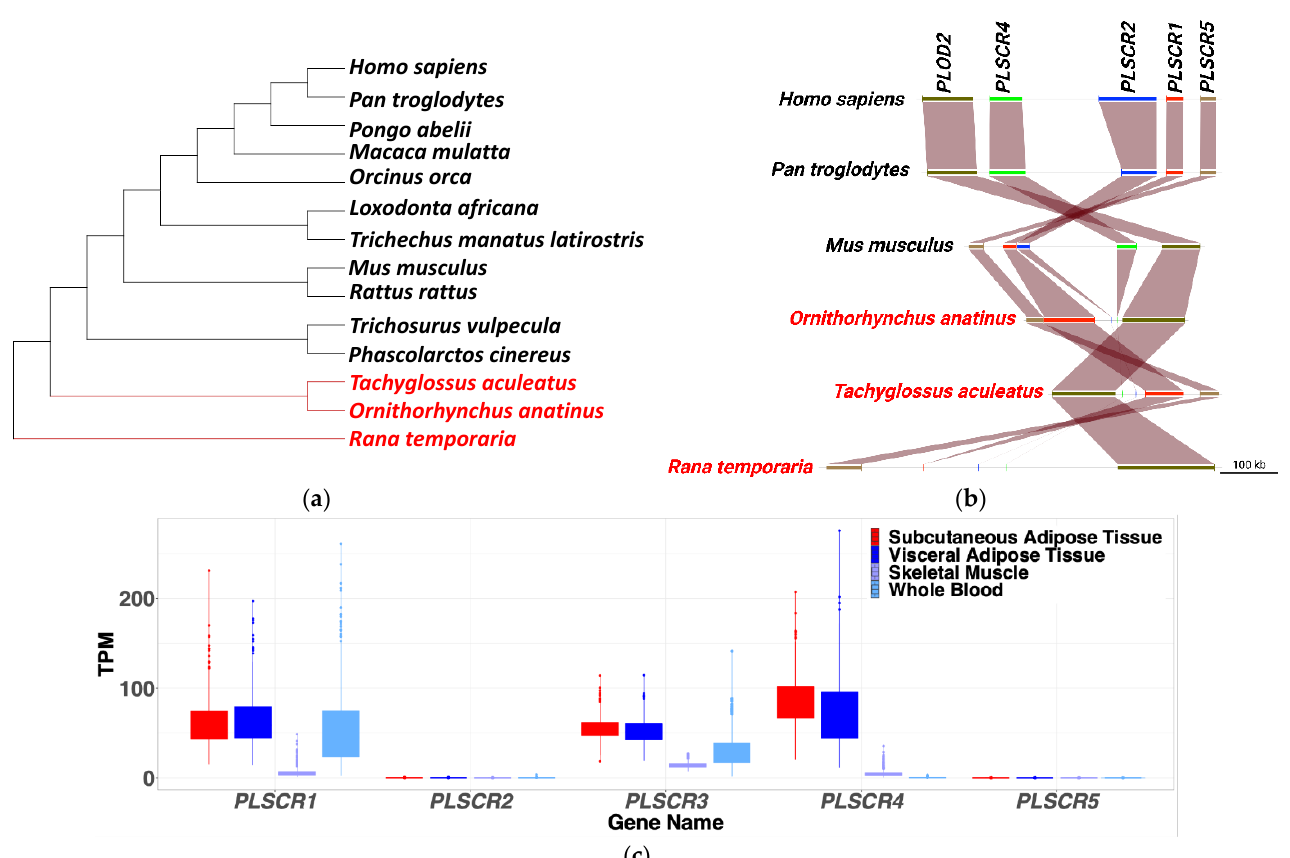
Figure 1. PLSCR genes synteny and expression patterns. ( a ) Phylogenetic tree of mammalian representatives showing the absence (labeled red) of PLSCR4 in Monotremata and the basal outgroup representative of amphibians ( Rana temporaria ). ( b ) Gene synteny of PLSCR genes including the species lacking PLSCR4 (labeled in red). PLOD2 was included because it is the neighboring gene of PLSCR4. ( c ) Expression profiles of PLSCR genes in different human tissues based on TPMs (Transcripts Per Million) obtained from the GTEx database. PLSCR4 is highly expressed in adipose tissue. PLSCR, phospholipid scramblase; PLOD2, Procollagen-Lysine,2-Oxoglutarate 5-Dioxygenase 2